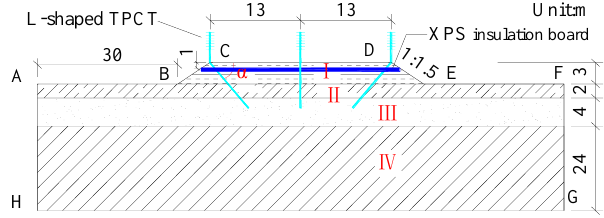
Figure 10. Calculation model of the composite subgrade.